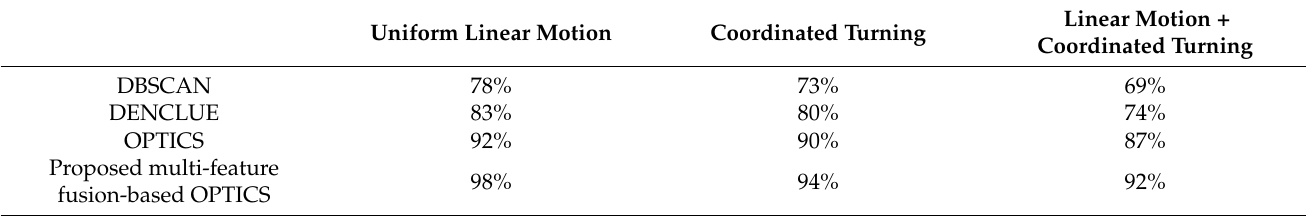
Table 2. The comparison of trajectory clustering